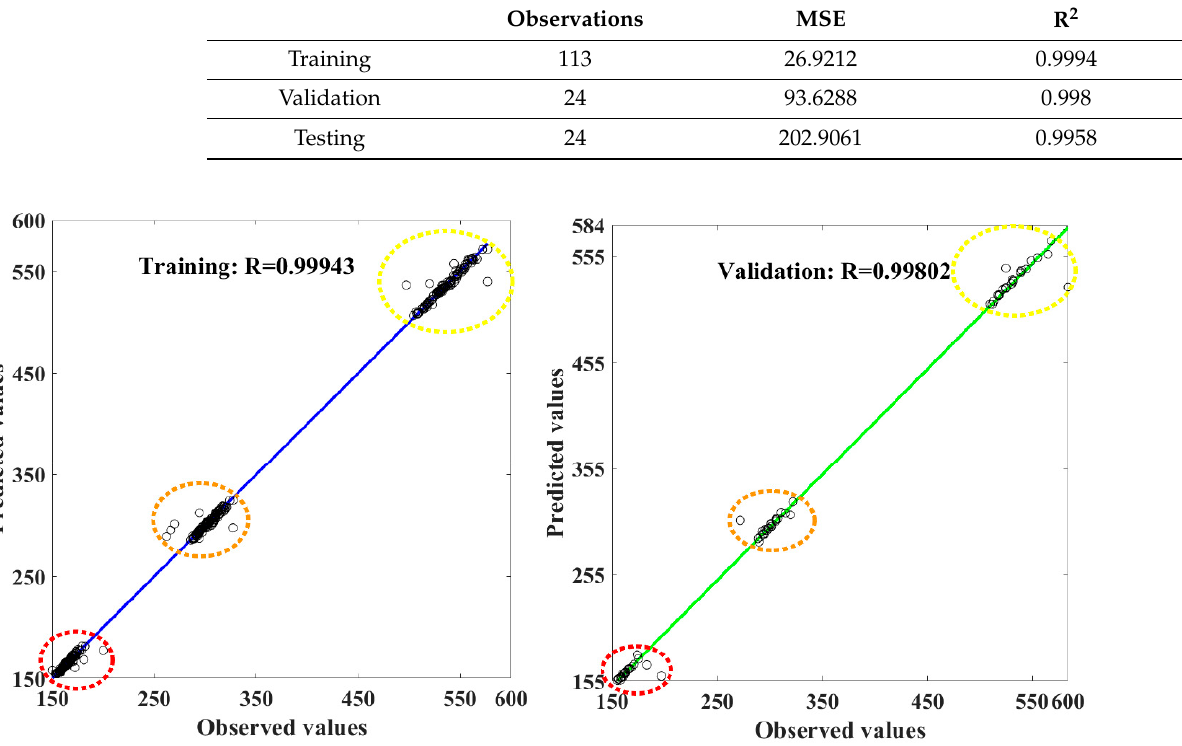
Figure 13. Correlation coe ffi cient for three threat zone prediction values from ANN model in testing and all together in LPG plant.